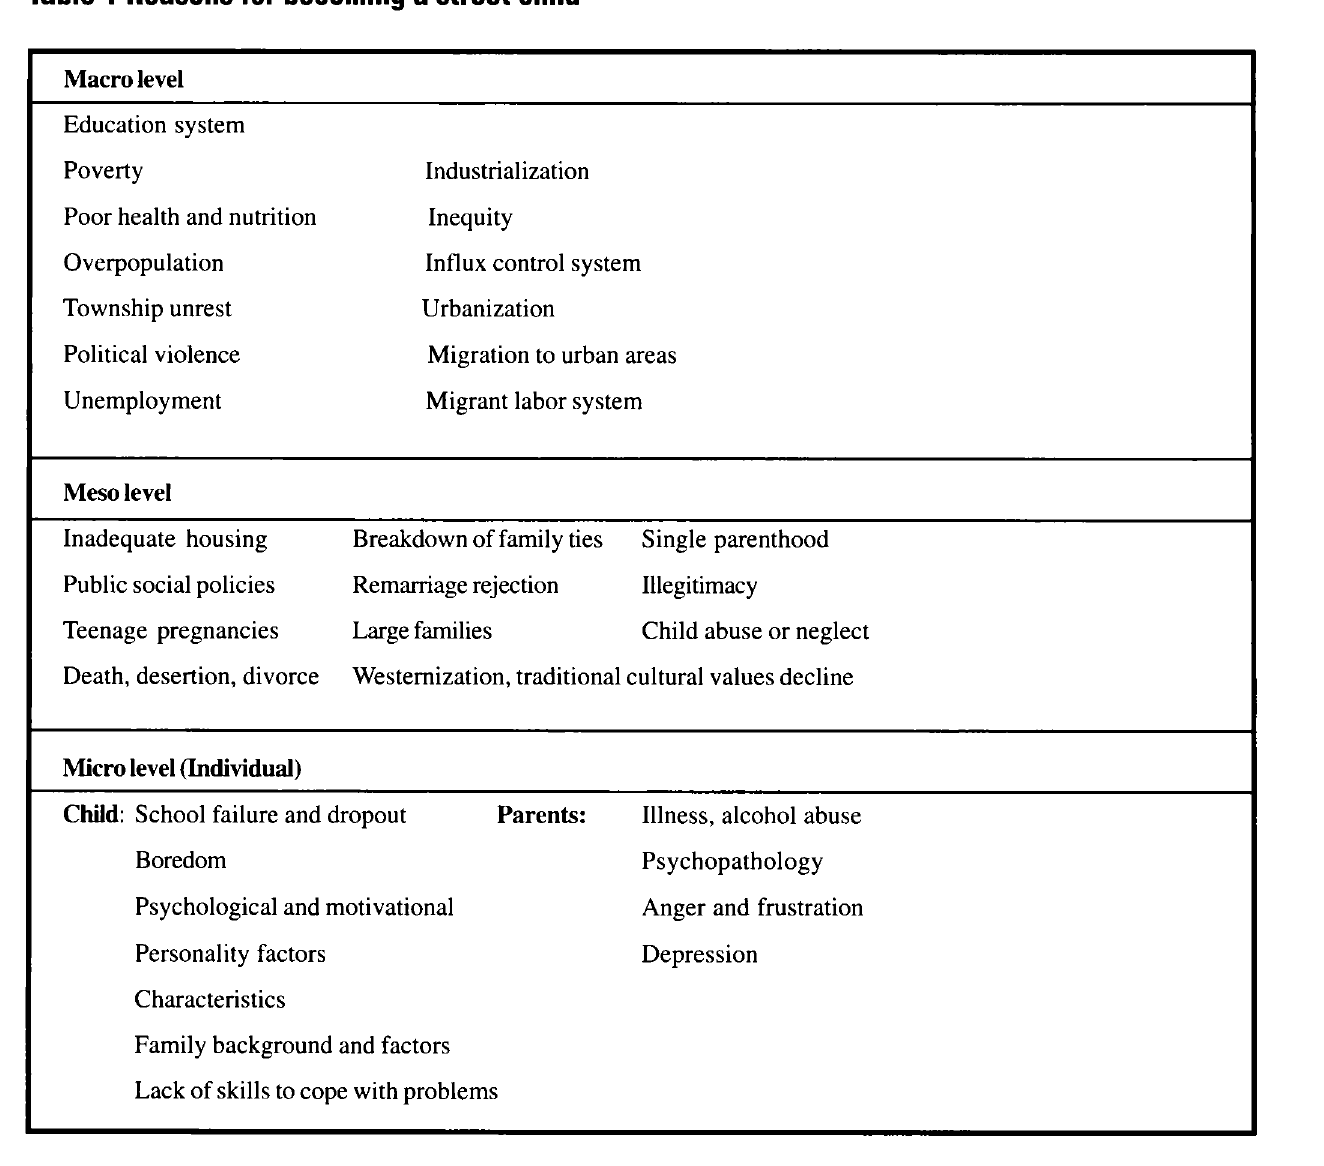
Table 1 Reasons for becoming a street